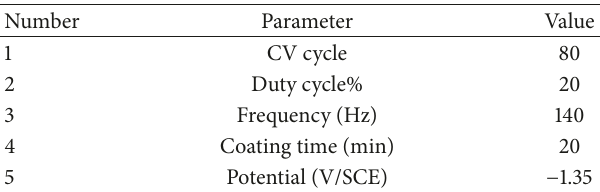
Table 1: Values of pulse electrodeposition (potential control) parameters used for rGO-Zn coating.